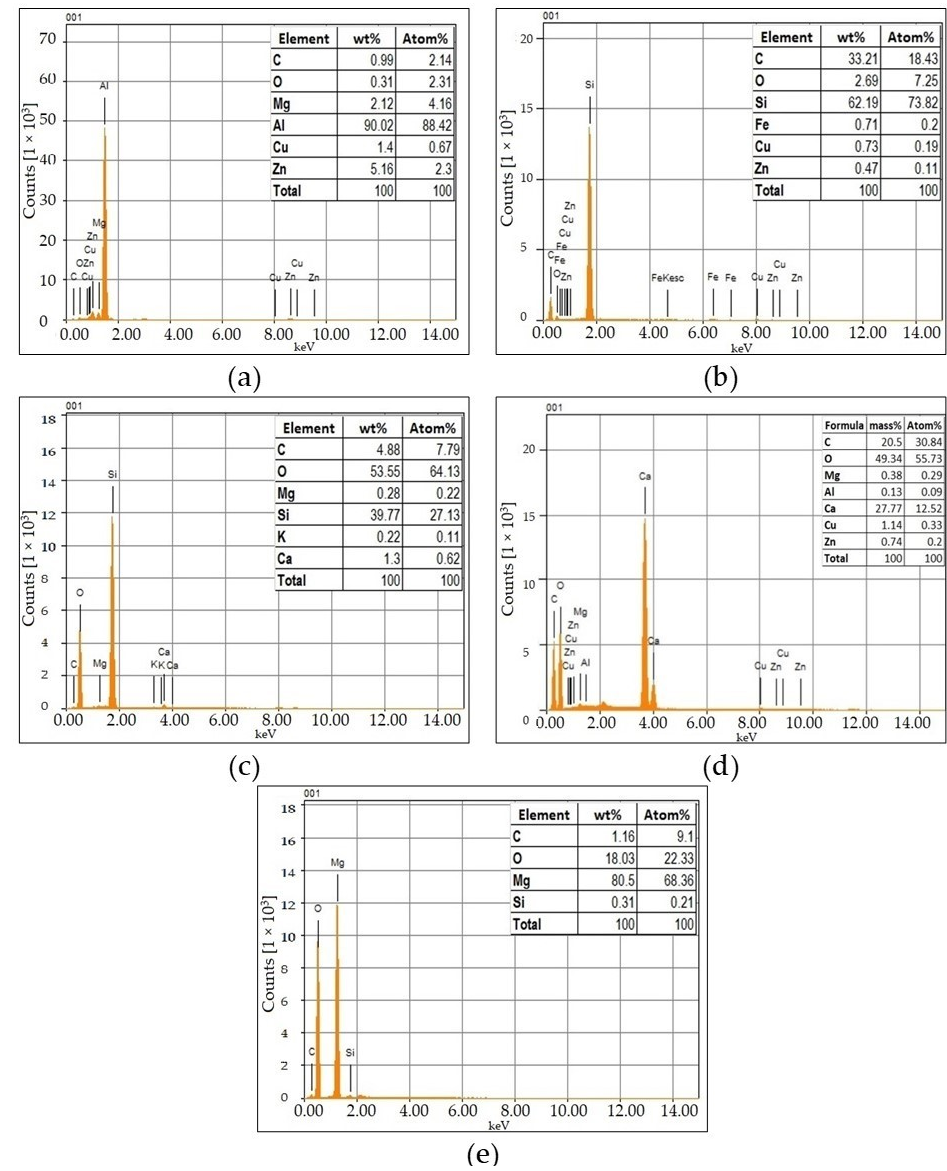
Figure 3. EDS of the raw materials ( a ) AA7075 (as received), ( b ) Silicon Carbide, ( c ) Rice Husk Ash, ( d ) Carbonized Eggshell ash ( e ) Mg Ribbon.